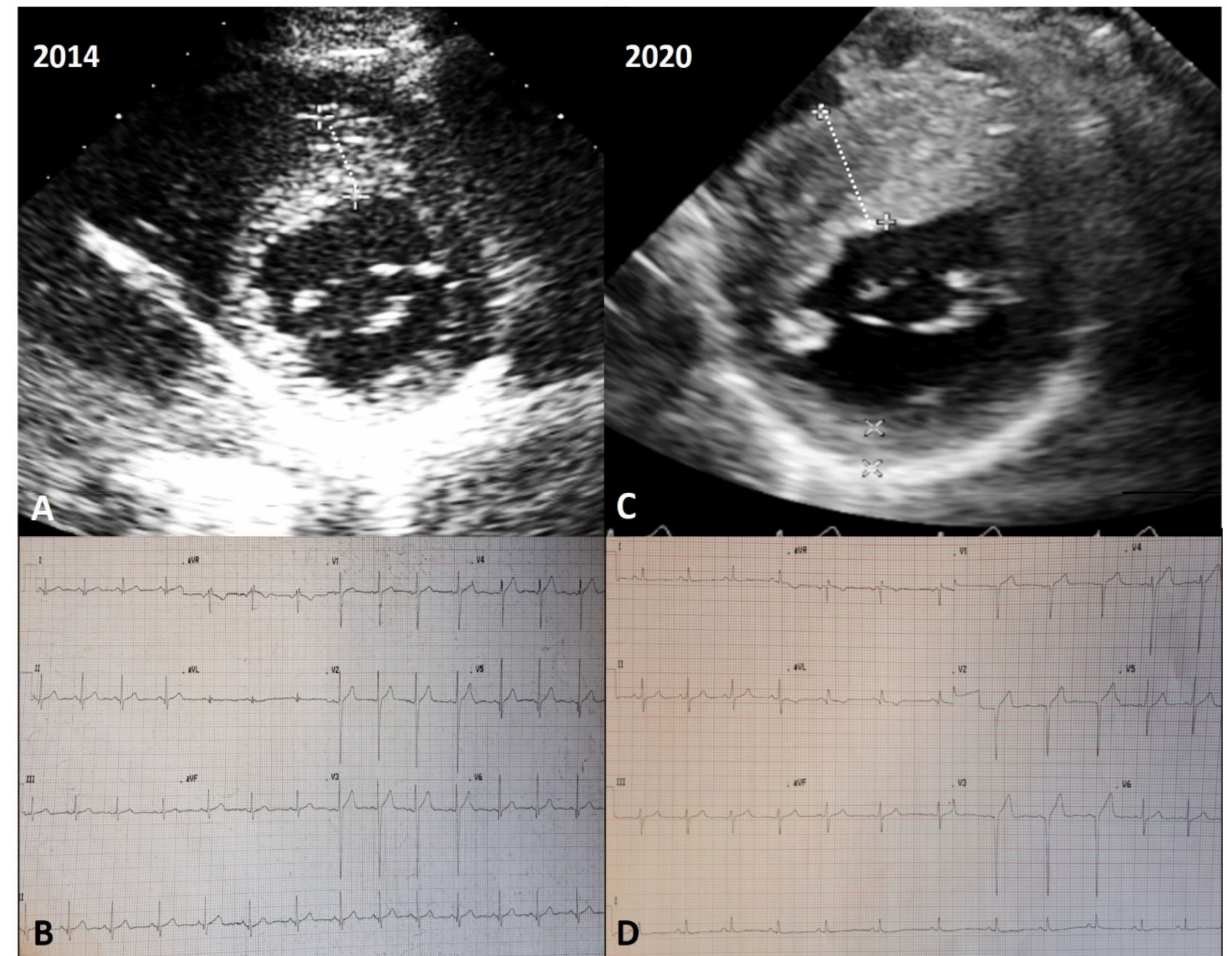
Figure 3. Echocardiographic and electrocardiographic findings in a patient with positive LV remodeling. A young male was diagnosed with non-obstructive HCM during a familial screening (mother affected) at 14 years of age, and since then followed at our outpatient clinic. At initial evaluation, the echocardiogram showed a maximal wall thickness of 16 mm at the level of the anterior septum ( A ), with signs of LV hypertrophy in the electrocardiogram ( B ). After 6 years, a significant increase in maximal wall thickening (24 mm) was found via echocardiography ( C ). The electrocardiogram (ECG) showed left axis deviation and the occurrence of Q waves in V1–V3 ( D ). At cardiac magnetic resonance imaging, the presence of intramural late gadolinium enhancement at the level of maximal hypertrophy was detected, and 24-h ECG Holter monitoring revealed a run of non-sustained ventricular tachycardia of 8 beats at rate of 160/min. He was implanted with a subcutaneous implantable cardioverter defibrillator for primary